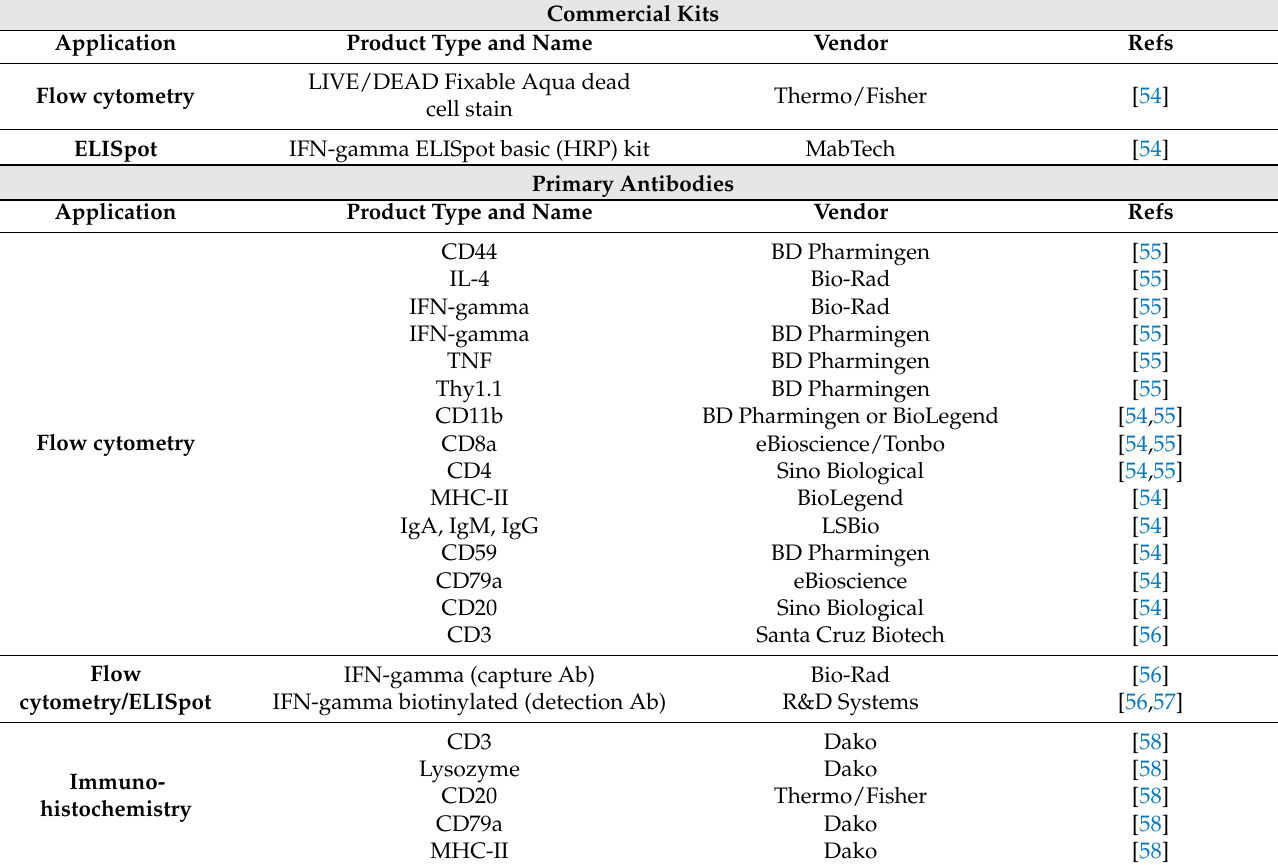
Table 1. Limited ferret-specific reagents are available for immune response and pathogenesis dissection following influenza virus infection or vaccination (modified from Albrecht et al. [38]). Commercial